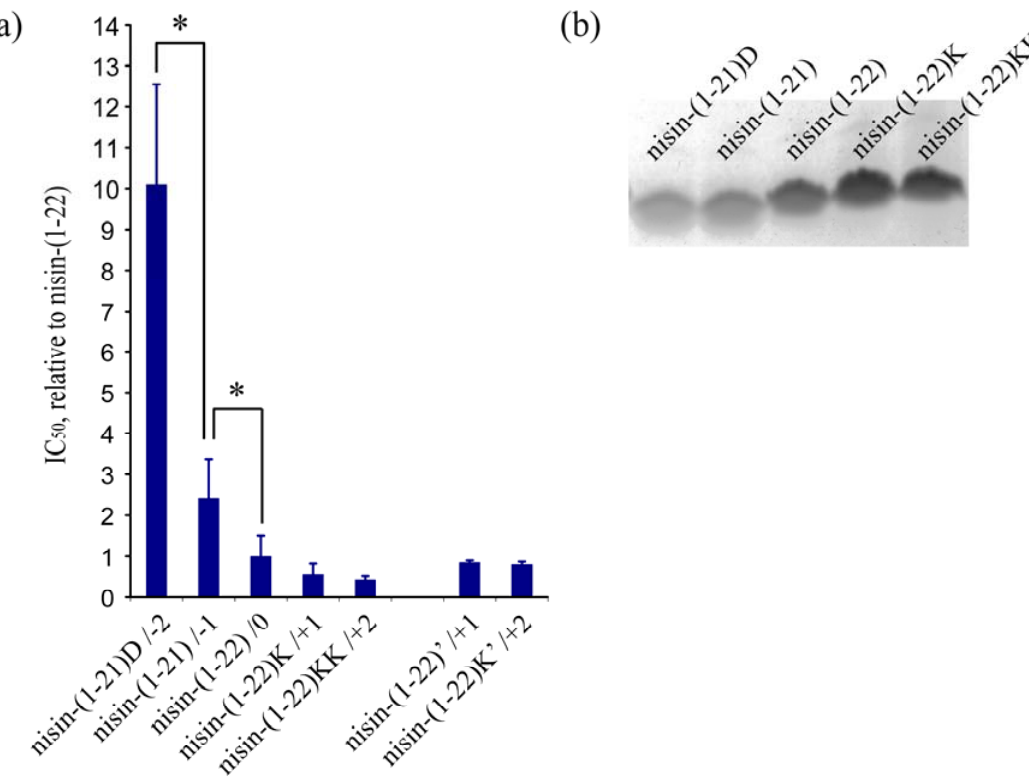
different C-terminal charge. (a) C-terminal positive charge enhances antimicrobial activity microwell dilution assay. Activities are displayed as the 50% inhibitory concentration (IC ). Apostrophe (’) denotes an amidated C-terminus. The C-terminal charge of the 50 peptides is given after the slash. An asterisk indicates significant difference ( P < 0.05) between the relative antimicrobial activities, as tested by a paired t test. Error bars indicate standard deviations. (b) Production levels of the truncated prenisin analogs visualized on a tricine SDS